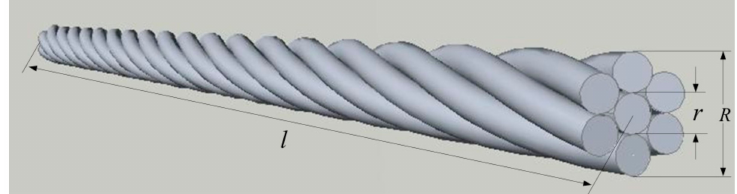
Figure 4. The structure of the steel